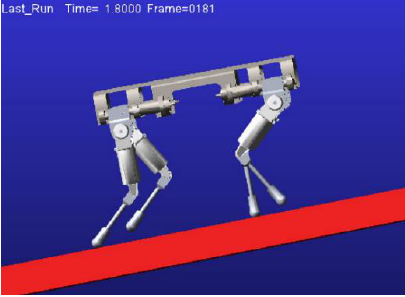
Figure 29. Simulation of Simulation 3.